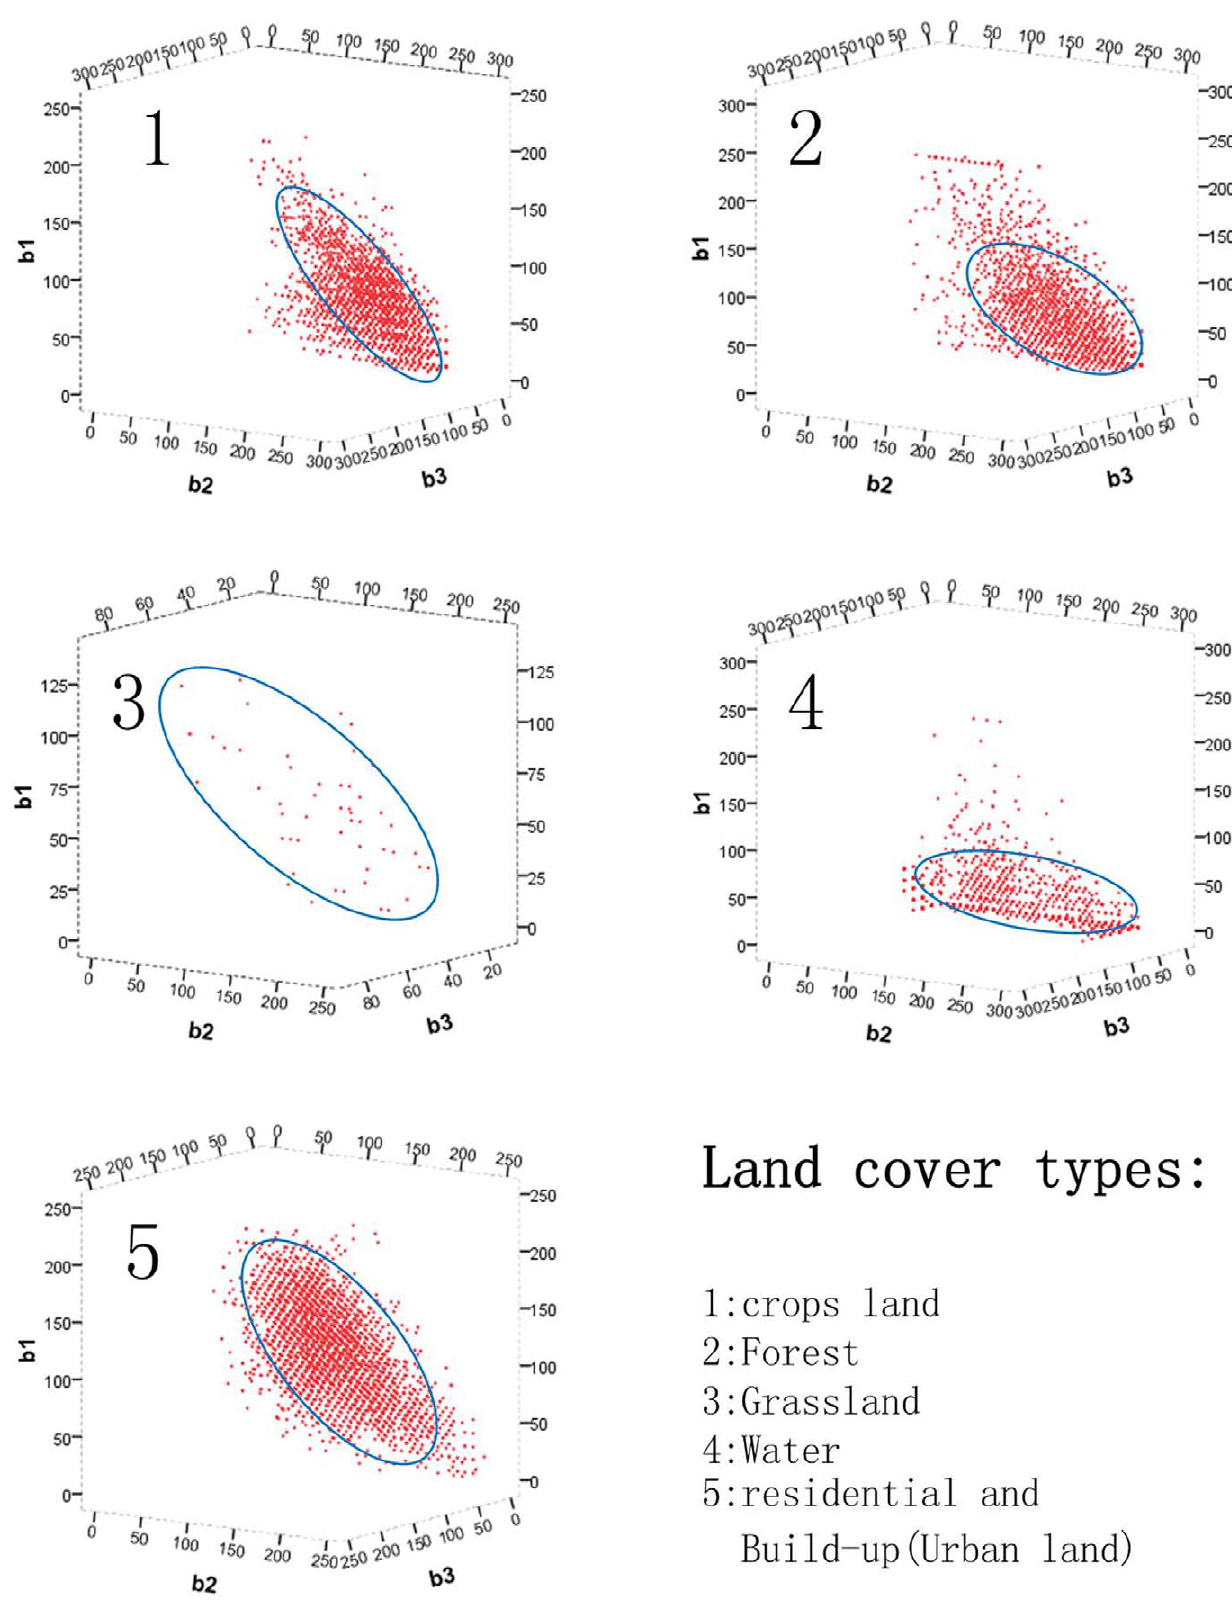
Figure 4. Three-dimensional scatter plots and feature space of five land cover types.